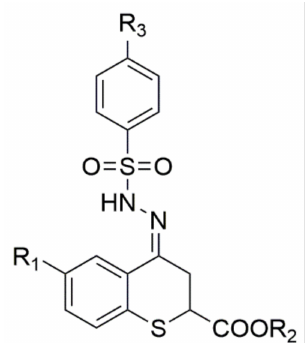
Figure 1. The structures of the target compounds reported in our previous